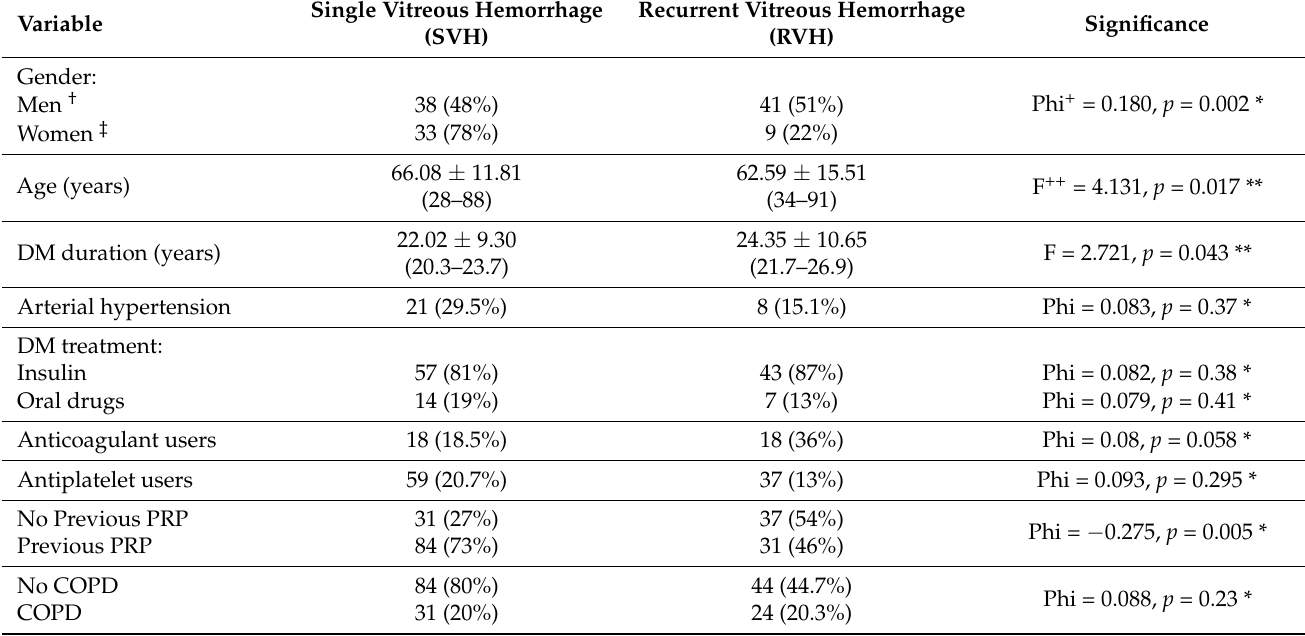
Table 1. Statistical study of differences between SVH and RVH groups of patients. UACR, urine albumin to creatinine ratio; eGFR, estimated glomerular filtration rate; COPD, chronic obstructive pulmonary disease; PRP, panretinal photocoagulation; Men † percentage with respect to all men of the sample, Women ‡ percentage with respect to all women of the sample; PVD patients with posterior vitreous detachment. *, chi-squared test; **, Mann–Whitney U test; ***, Student’s t -test. Phi + , Mathew’s correlation coefficient. F ++ ,